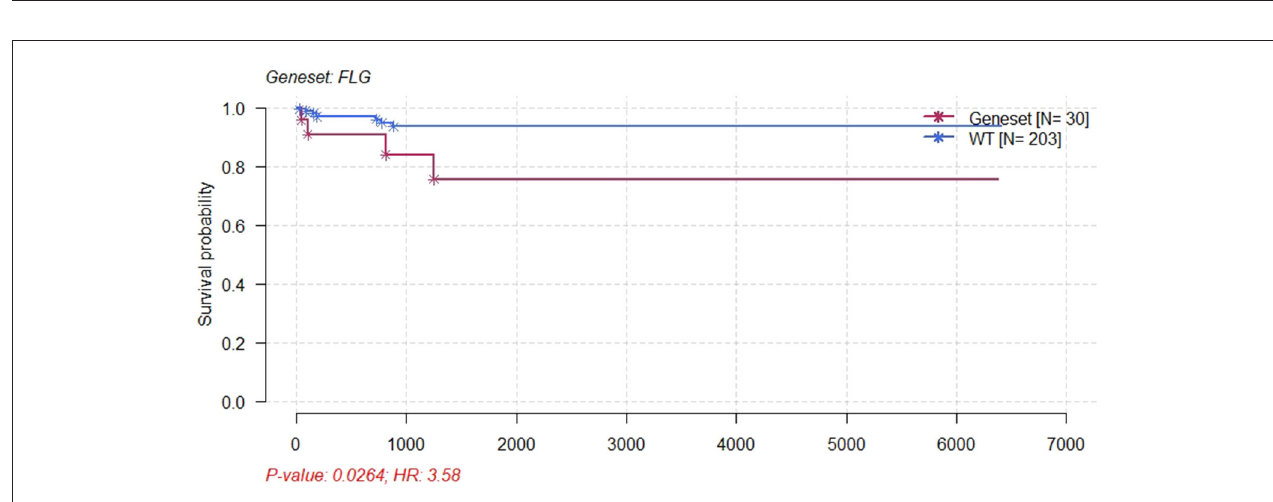
FIGURE 8 | The expression of APOBEC3B in validation datasets. (A) The expression of APOBEC3B in GSE63678, (B) the expression of APOBEC3B in GSE63541, and (C) the expression of APOBEC3B in GES6791.